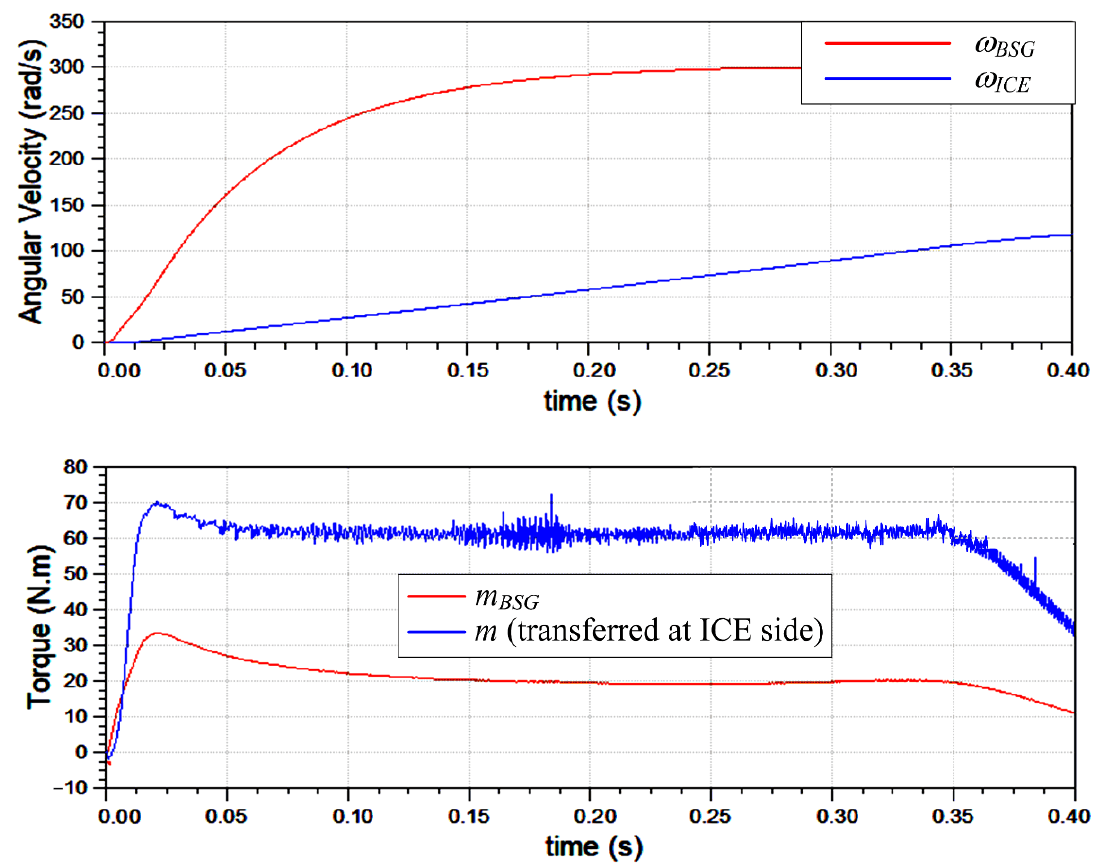
Figure 14. Results of MATLAB/Simulink TM co-simulation with the FEAD EXCITE TM model [10].